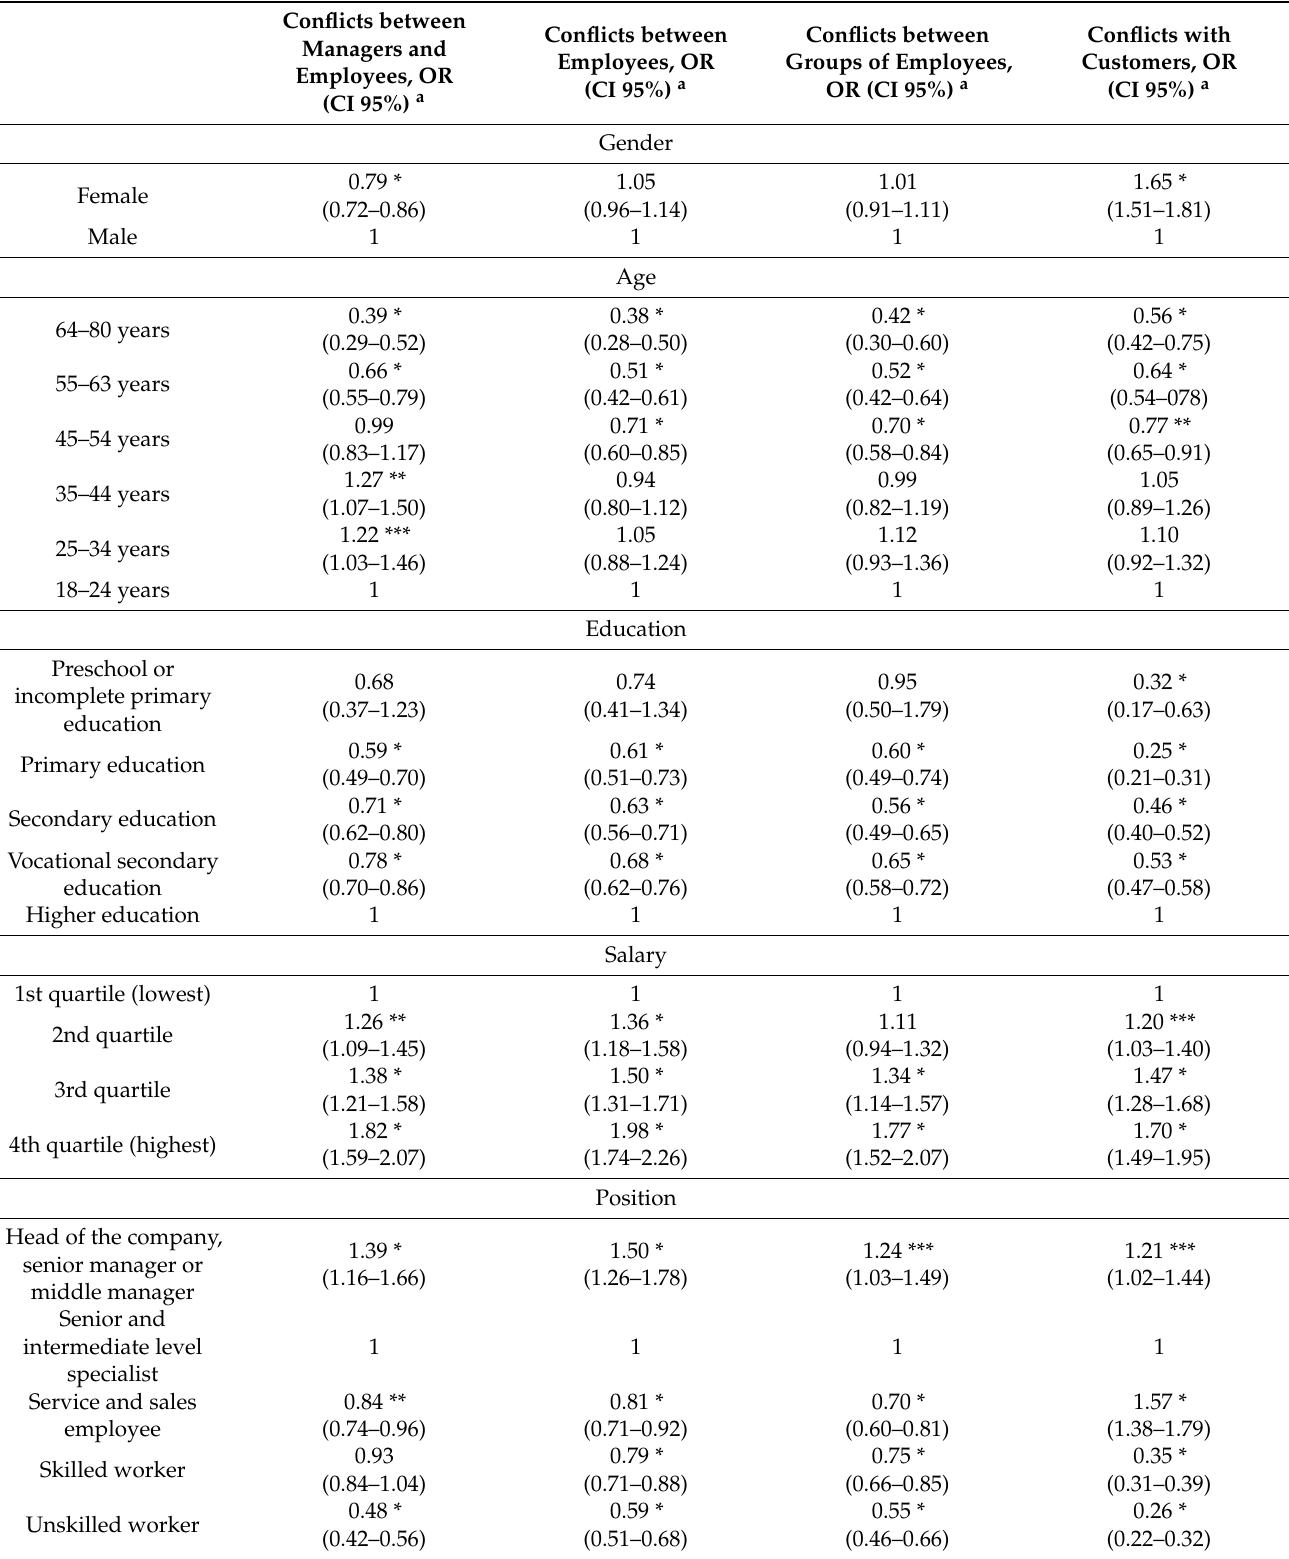
Table 3. Unadjusted odds of conflicts at work in association with the socio-demographic factors of